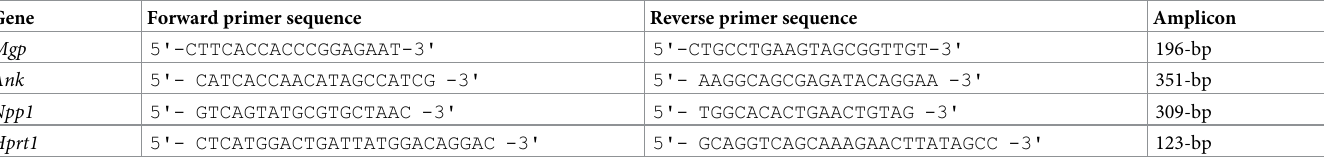
Table 1. Sequences of the PCR primer.